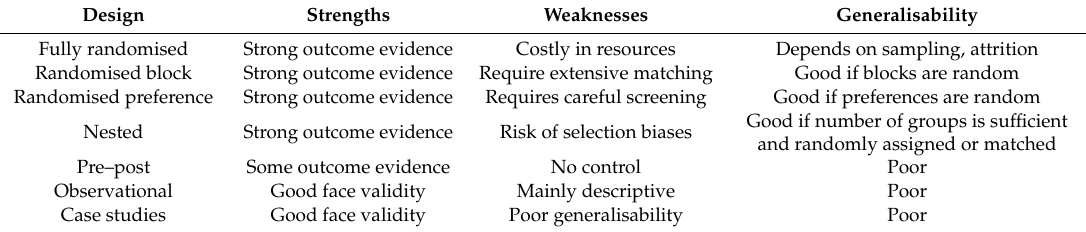
Table 1. Design approaches relevant to animal welfare behaviour change